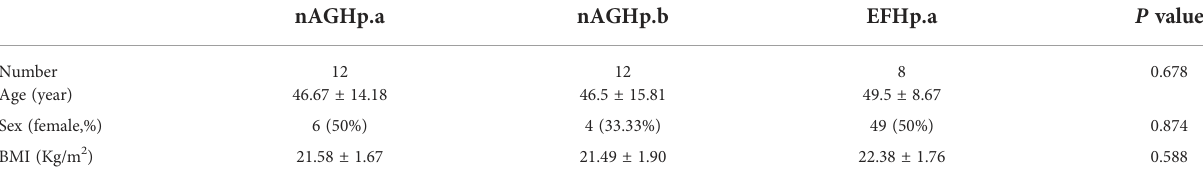
TABLE 1 Clinical baseline data among three